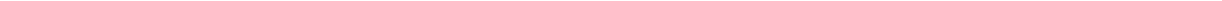
Fig. 8 Multiple dysregulated cellular processes in KRAS de fi cient cells. a Unsupervised hierarchical clustering dendrograms of 8988T and A13 clones indicated clean segregation between KRAS intact and de fi cient (KO) cells within each cell line. b Network representation of overlapping enriched GSEA/ MSigDB gene sets in the A13 knockout signature ( p < 0.05, FDR < 0.25). Each circle represents a gene set with circle size corresponding to gene set size and intensity corresponding to enrichment signi fi cance. Red is upregulated and blue is downregulated. Each line corresponds to minimum 50% mutual overlap with line thickness corresponding to degree of overlap. Cellular processes associated with related gene sets are listed. c Network representation of overlapping enriched GSEA/MSigDB gene sets in the 8988T knockout signature ( p < 0.005, FDR < 0.1). d Heat map of a 32-gene combined knockout signature generated through ICA analysis of A13 and 8988T gene expression data sets. Gene names are listed in rows. Row normalized gene expression values are shown where red designates relative upregulation and blue designates relative downregulation. e Kaplan – Meier plots of survival of human patients from the TCGA PDAC cohort whose tumors most correlated (top quintile) and least correlated (bottom quintile) with the combined knockout signature in d (UP genes only). Log-rank (Mantel – Cox) p value is shown. f Kaplan – Meier plots of survival of human patients from the ICGC cohort